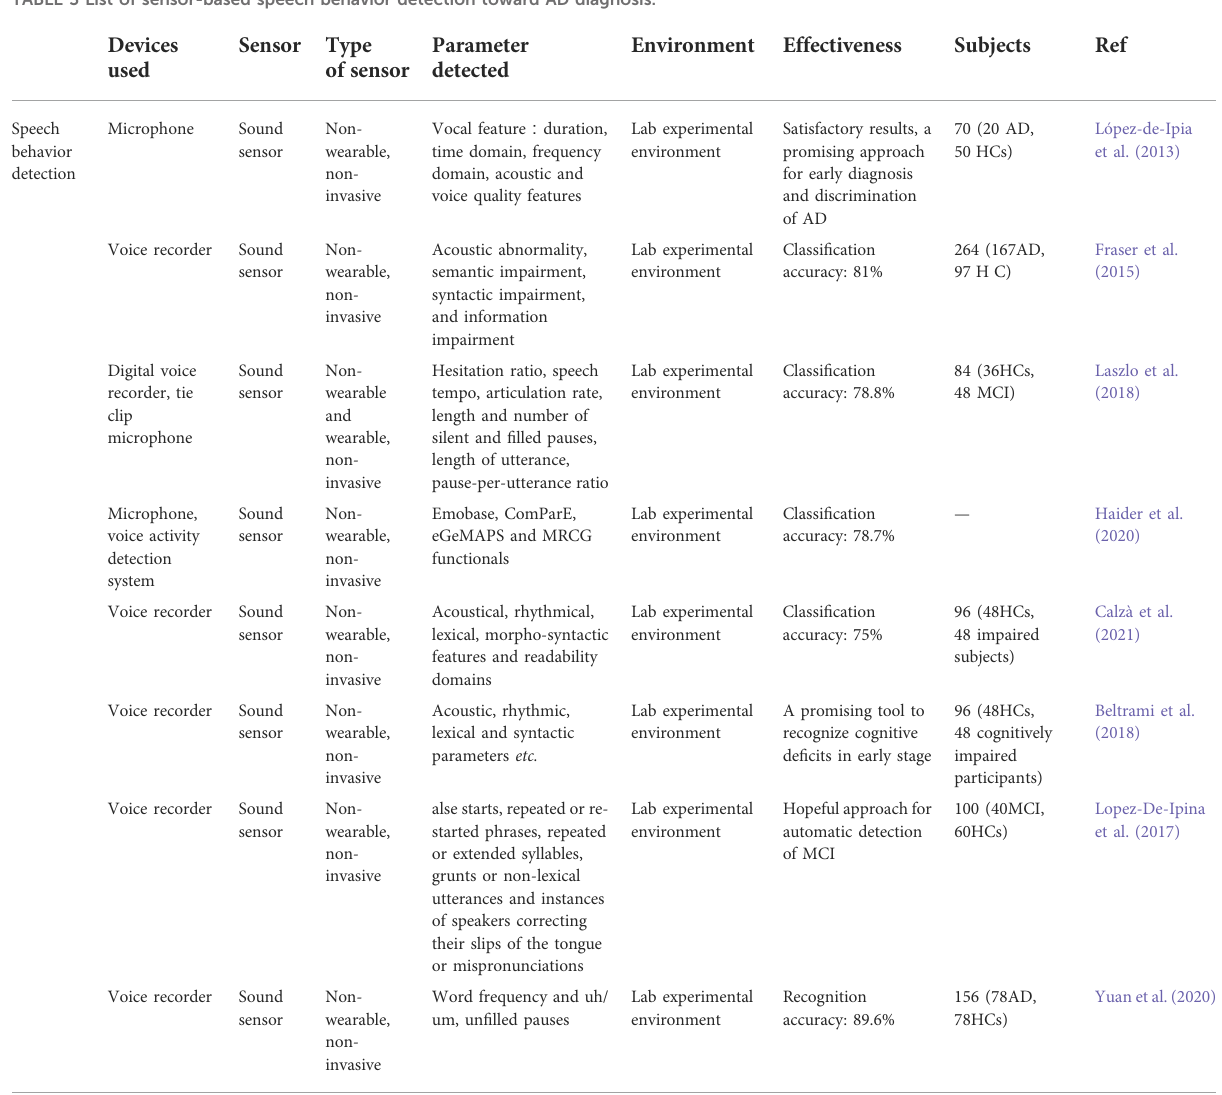
TABLE 3 List of sensor-based speech behavior detection toward AD